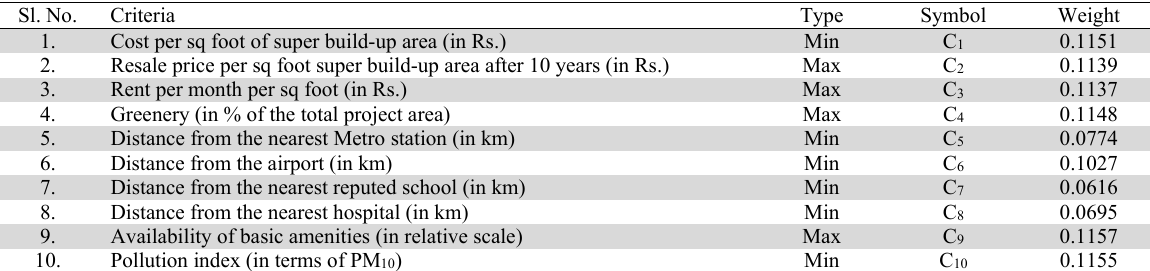
Details of the evaluation criteria Sl.